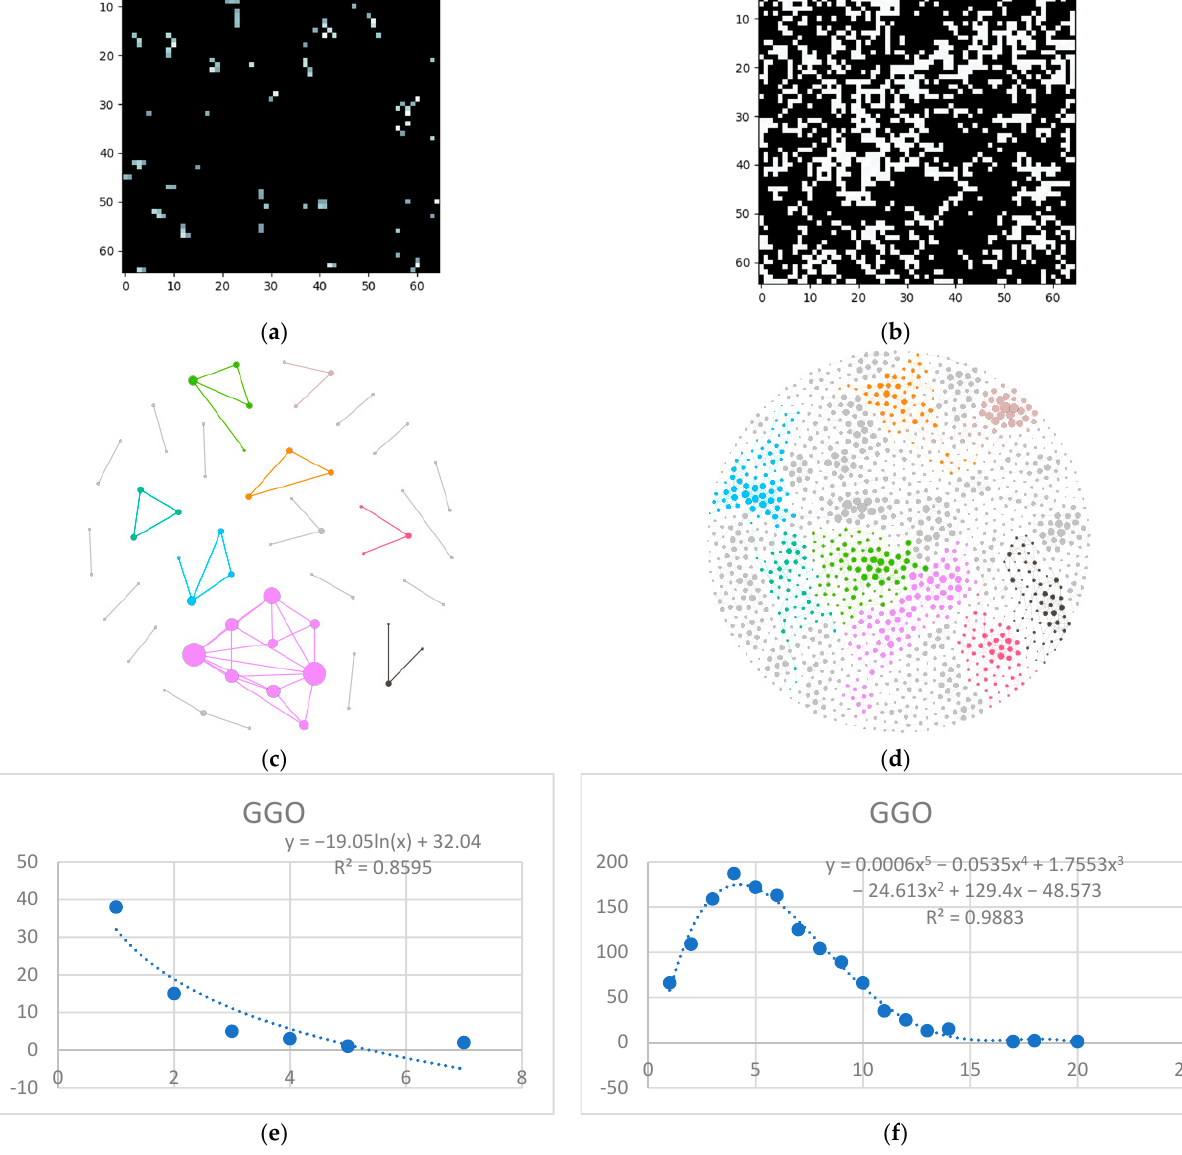
Figure 6. GGO processing ( a ) HU filtered layer for the normal sample; ( b ) HU filtered layer for the DILD sample ( c ) Complex network built according to the proposed algorithm corresponding to the normal sample, Fruchterman–Reingold render layout, node sizes proportional to node degrees, edge width invariant (1.5 pixels). ( d ) Complex network built according to the proposed algorithm corresponding to the DILD sample, Fruchterman–Reingold render layout, node sizes proportional to node degrees, edge width invariant (1.5 pixels). ( e ) Degree distribution of the normal sample network ( f ) Degree distribution of the DILD sample network. Equations for curve fit and R 2 are also presented for the relevant distributions. Last but not least, is the consolidation layer (Figure